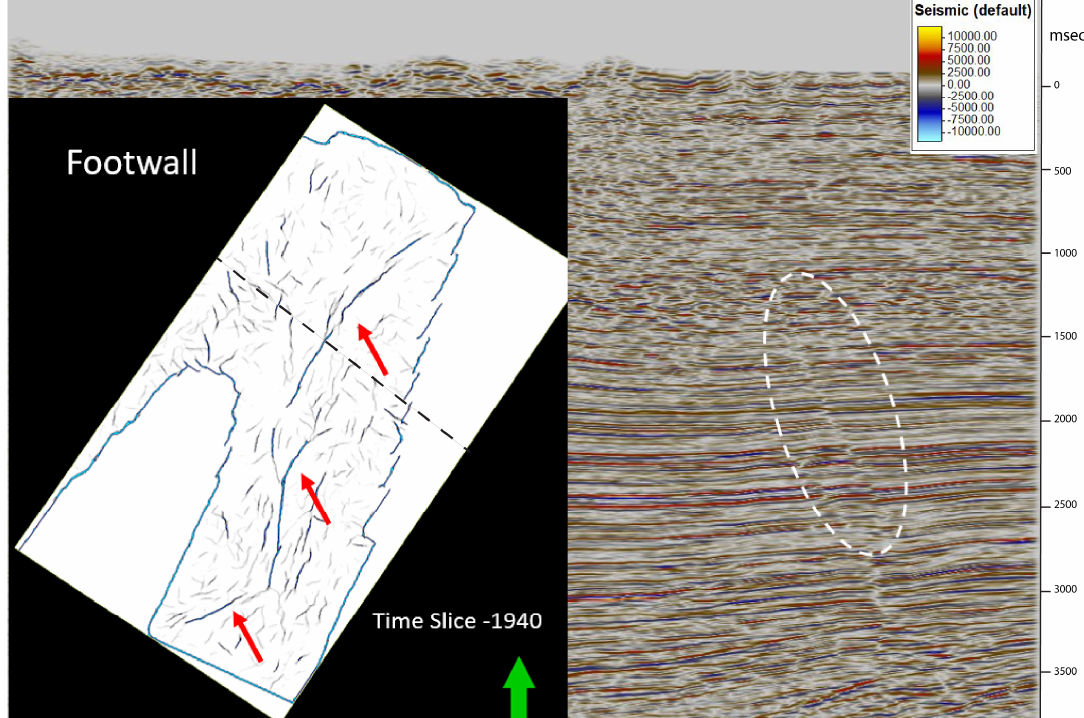
Figure 14. Seismic amplitude profile showing a normal fault (dashed white oval on the right), and the ant-tracking time slice (left) at 1940 msec showing the profile location (dashed black line) and en-echelon normal fault (red arrows).